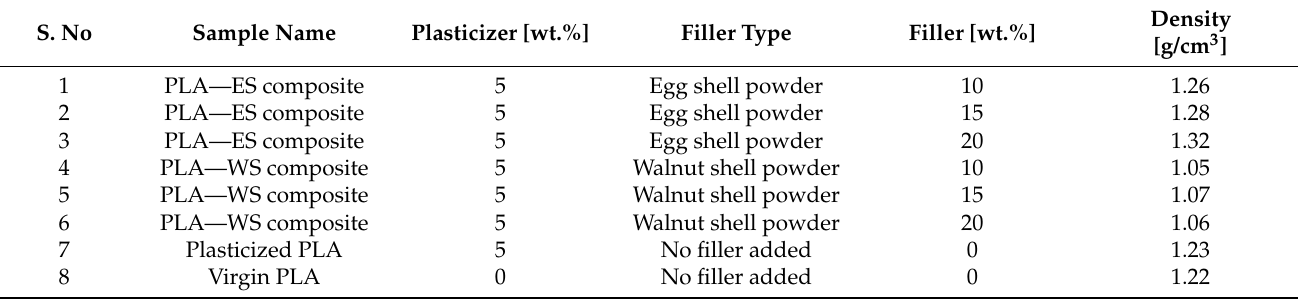
Table 2. Types of samples produced for